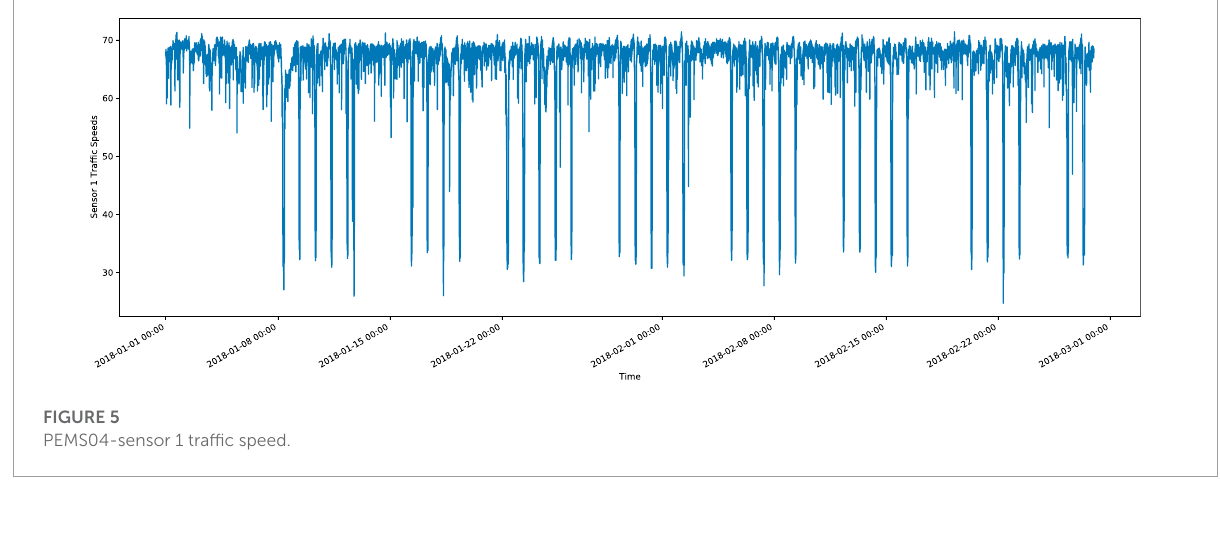
FIGURE 5 PEMS04-sensor 1 traffic speed.